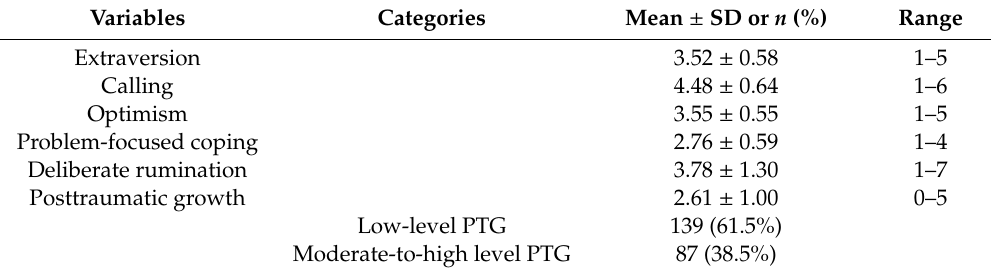
Table 2. Extraversion, calling, optimism, problem-focused coping, deliberate rumination, and posttraumatic growth.